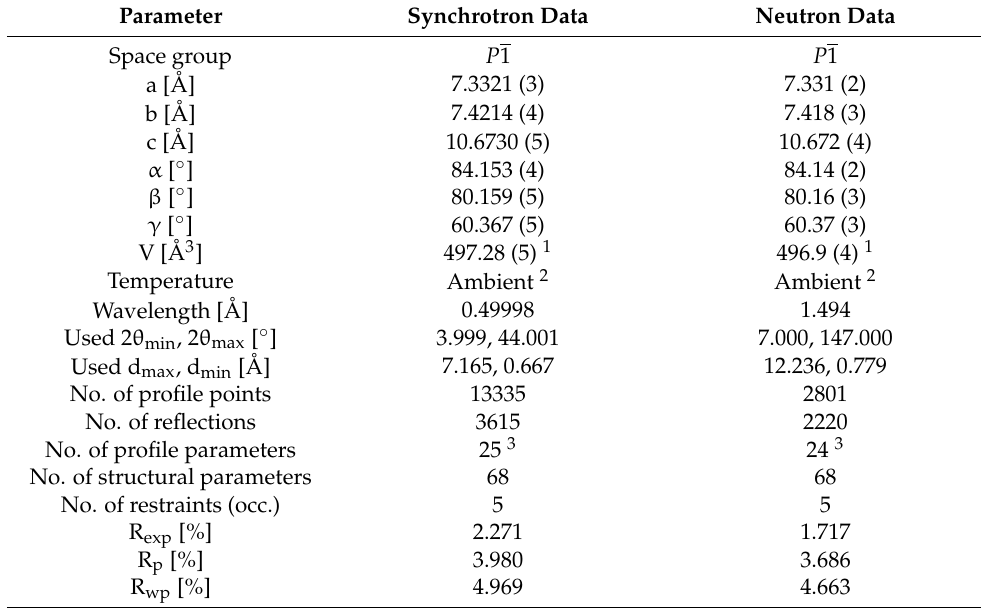
Table 1. Crystal data and Rietveld refinement parameters of La 0.987 Ti 1.627 Nb 3.307 O 13 .